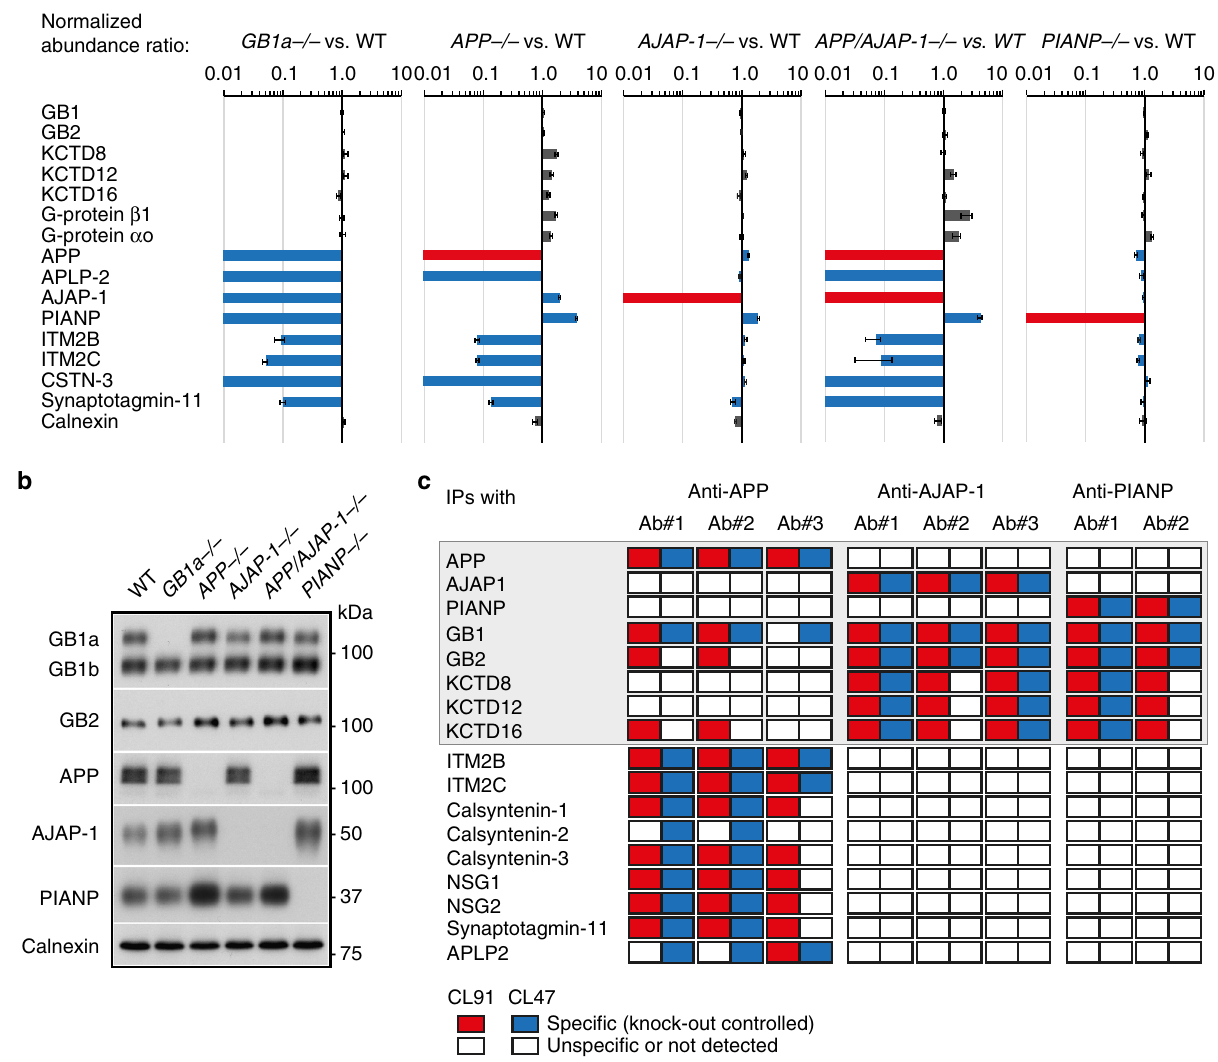
Fig. 1 Proteomic analysis of native GBR complexes. a Protein abundance ratios for GBR proteome constituents ( n = 3 measurements, data are presented as mean ± s.e.m.) in GBR IPs from membrane fractions of WT, GB1a − / − , APP − / − , AJAP − / − , APP/AJAP − / − , and PIANP − / − brains solubilized with the intermediate stringency detergent CL91 (normalized to GB1/2). APP, AJAP-1, and PIANP directly bind to GB1a while APLP2 binds to GB1a via APP. Common changes in the GBR proteomes of GB1a − / − and APP − / − mice identify APP as a putative linker between GB1a and the traf fi cking machinery. b Immunoblot analysis of GBR constituents in brain membrane preparations from knock-out mice. Calnexin serves as a loading control. Lack of APP upregulates PIANP. c APP, AJAP-1, and PIANP assemble into independent GBR complexes. The table summarizes results of co-immunoprecipitations with anti-APP, anti-AJAP-1, and anti-PIANP antibodies from mouse brain membranes solubilized with mild (CL47) and intermediate stringency (CL91) detergents. Knock-out brains were used in control immunoprecipitations. Source data are provided as a Source Data fi